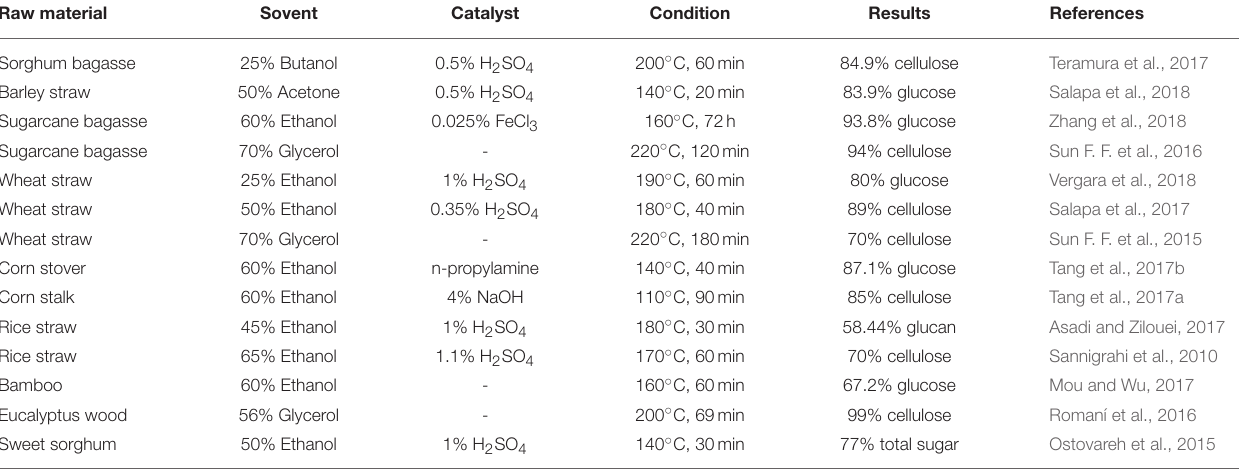
TABLE 2 | Effect of organosolv pretreatment on different lignocellulosic substrates. Raw material Sovent Condition